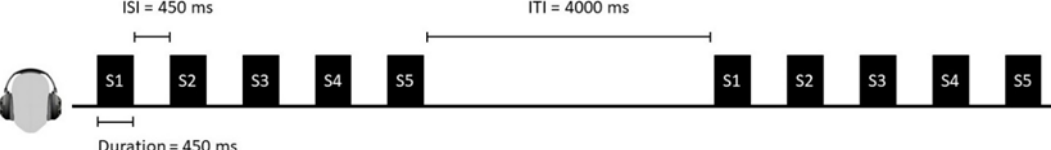
Figure 1. A demonstration of the short-term habituation paradigm. The word-forms in each list were divided into five blocks in which one word-form out of five for each condition only appeared in one block. In a block, a train carrying the same word-form was delivered 11 times. Four foil word-forms were included and varied for each block but kept the same across the two lists. A train of a foil word-form was pre- sented five times in a block. The trains of stimuli were pseudo-randomly presented in a way that those of the same condition were presented no more than three times in a row. A 1.5 min stimulus-free break was set between every two blocks. 3.3. EEG Data Acquisition The EEG of each participant was recorded in a sound attenuated cabin with constant, dim lightness, seated in front of a PC monitor placed at a distance of about 1.2 m. They were randomly administered to be exposed to one stimulus list and were suggested to refrain from unnecessary body movement. During the EEG recording, auditory stimuli were delivered binaurally and passively via a pair of Sennheiser headphones. To avoid that the habituation of AEPs is potentially confounded with selective attention [26], par- ticipants were instructed to watch a silent cartoon movie without subtitles, and asked to remember the contents for a movie comprehension test which was administered after the EEG acquisition. The comprehension test required participants to read 12 statements about the movie and judge whether they matched the contents of the movie by choosing either “Yes”, “No”, or “Cannot remember”. Moreover, they were encouraged to ignore any sounds that would be presented from the headphones. The EEG signal was recorded by a LiveAmp amplifier (Brain Products) via 32 Ag/AgCl electrodes situated on an elastic cap, according to the extended international 10- 20 system, with a 500 Hz sampling rate. One electrode was placed at the right infraorbital ridge to monitor ocular movement. The online reference was FCz and the ground elec- trode was AFz. The impedance of electrodes was kept below 5 kΩ. 3.4. EEG Data Analysis The offline processing of the EEG data was performed in Brain Vision Analyzer 2.0 (Brain Products). A band-pass filter between 1 and 30 Hz was first applied, and then, the filtered data were re-referenced to the average amplitudes recorded from the two mas- toids. Voltage levels exceeding ±40 μ v in any channel were rejected as artefacts. Then, the surviving EEG recording was segmented separately for the five presentations (i.e., S1 – S5) of each stimulus type, with an epoch of 600 ms, between −100 ms before and 500 ms after the stimulus onset. Baseline was corrected according to the pre-stimulation responses (−100 to 0 ms). Peak amplitudes of N1 were quantified with a peak-to-peak measurement by calcu- lating the amplitude difference between an N1 peak and the peak of its preceding promi- nent positive component P1 ( cf . [56,57]). For this measurement, the peak amplitudes of P1 and N1 were detected in two time-windows, respectively: 40 – 100 ms (P1) and 80 – 170 ms (N1) for each type of stimuli at every presentation position, per participant. The time win- dows were defined by referring to previous studies (e.g., [58,59]) and adjusted according to visual inspection of the data. The degree of N1 habituation at each presentation position was quantified by a habituation index, which is calculated as the ratio of the N1 peak amplitude in a repeated position (S2 – S5) to that in the initial presentation (S1) for each of the four stimulus types. Accordingly, the greater the index is, the less the relative auditory habituation takes place. The formula of its calculation is: